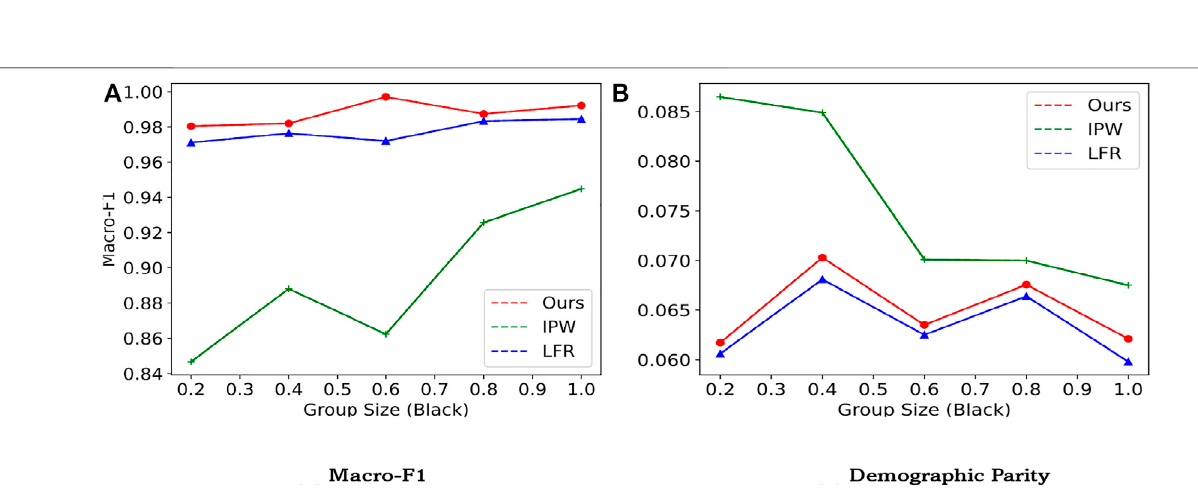
Frontiers in Big Data |